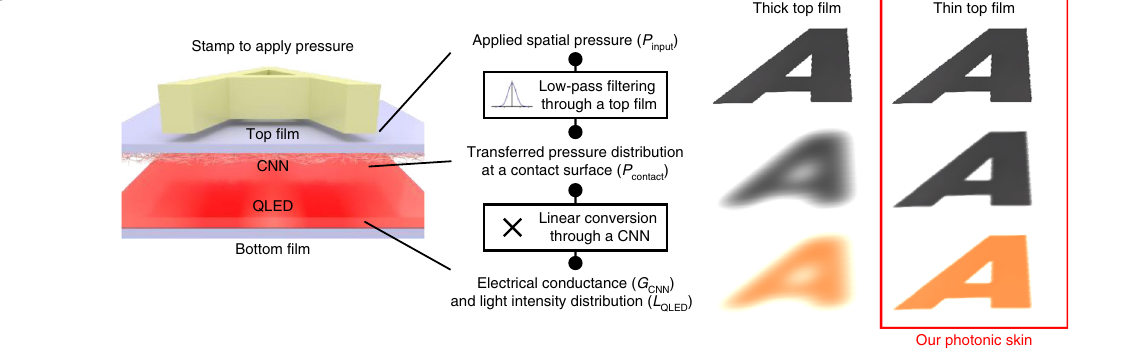
t µ m ( e ) and t µ m ( f ). The top ~ 10 top ~ 1